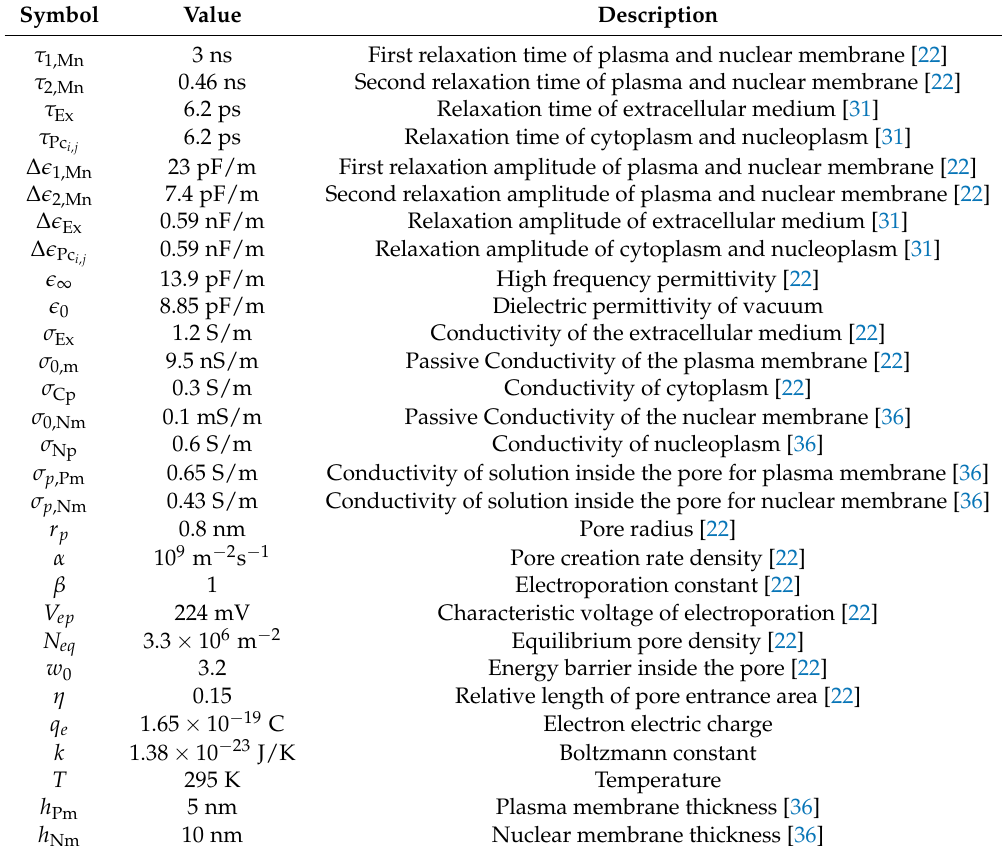
Table 2. Polarization, electric, geometrical and EP